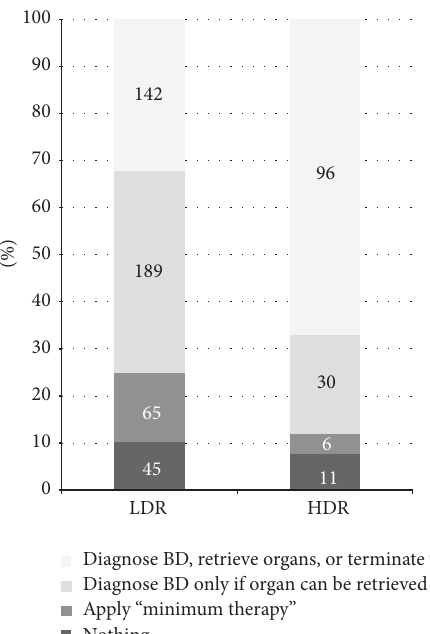
Figure 3: What would you do if clinical signs of brain death were